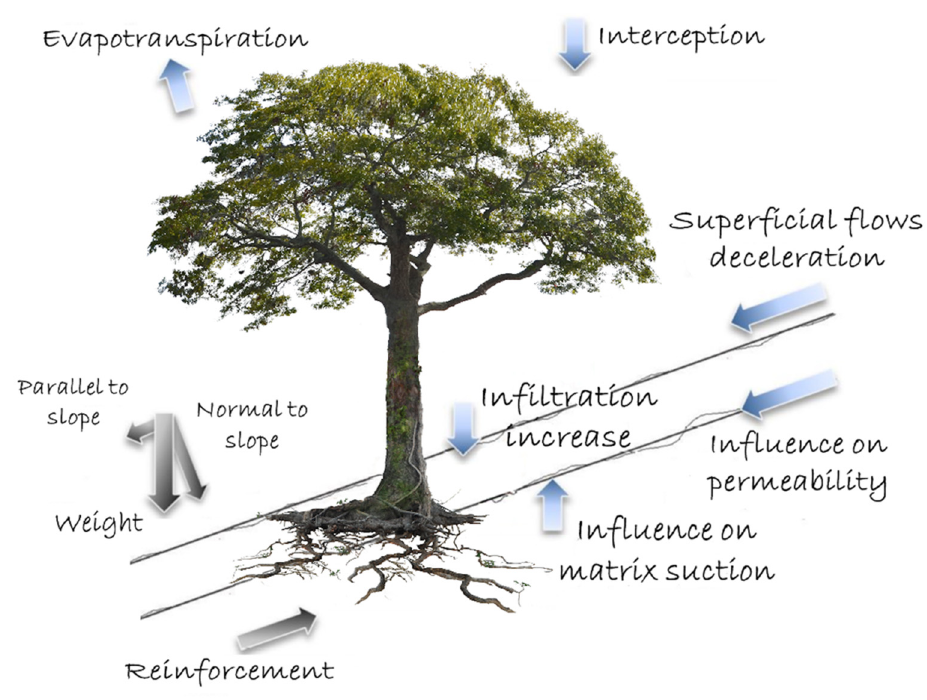
Figure 1. Mechanical and hydrological main effects of vegetation on slopes’ soil behavior.